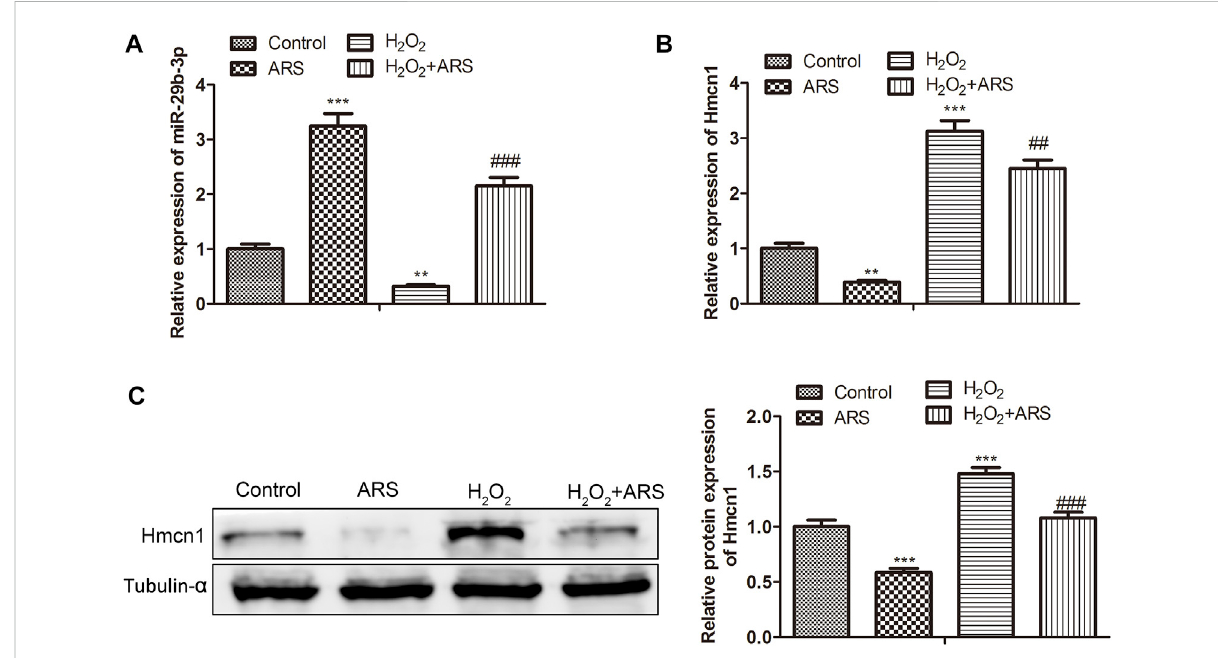
FIGURE 4 MiR-29b-3p and HMCN1 are the target genes of ARS on myocardial I/R injury. The expression of (A) miR-29b-3p and (B) HMCN1 in indicated groupstestedusingqRT-PCR; (C) ProteinexpressionofHMCN1evaluated via Westernblotting. N =3,** p < 0.01,*** p < 0.001vs.Control; ## p < 0.01, ### p < 0.001 vs. ARS or H 2 O 2